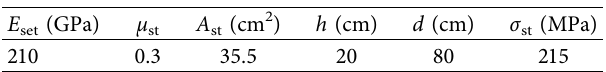
Table 2: Calculation parameters of the steel